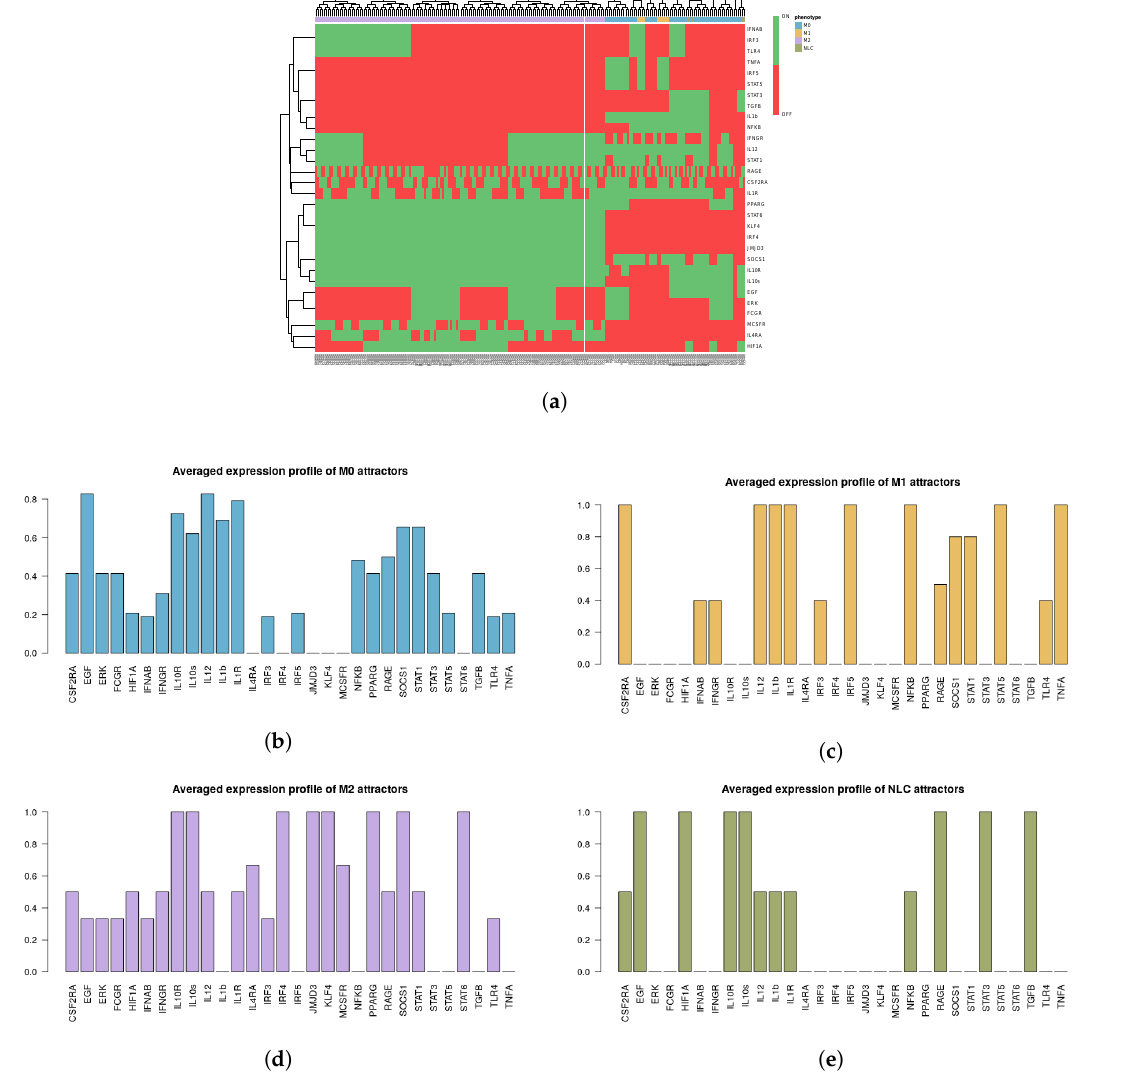
Figure 2. ( a ) Heatmap of 214 attractors. ( b – e ) Averaged attractors for each category: M0, M1, M2 and